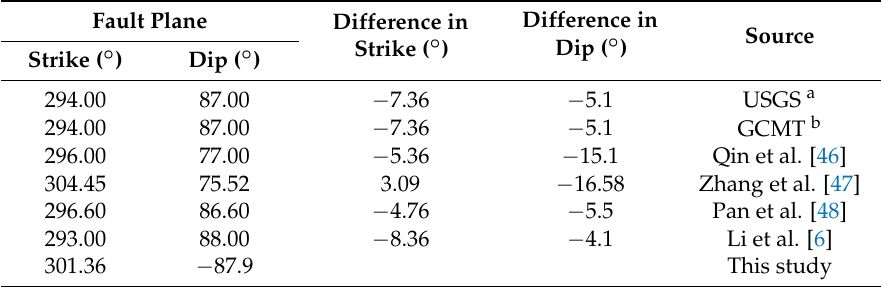
Table 3. Comparison of source parameters of the 2009 Ms6.0 Yao’an earthquake Difference in Fault Plane Difference in Source Dip ( ◦ ) Strike ( ◦ ) Strike ( ◦ ) Dip ( ◦ ) 294.00 87.00 − 7.36 − 5.1 USGS a 294.00 87.00 − 7.36 − 5.1 GCMT b 296.00 77.00 − 5.36 − 15.1 Qin et al. [46] 304.45 75.52 3.09 − 16.58 Zhang et al. [47] 296.60 86.60 − 4.76 Pan et al. [48] 293.00 88.00 − 8.36 301.36 −